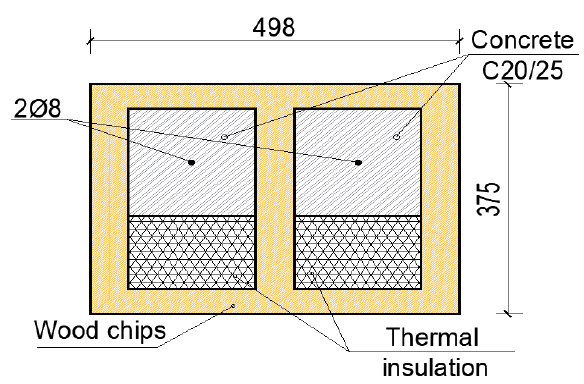
Figure 7. Configuration of block CBWC2.